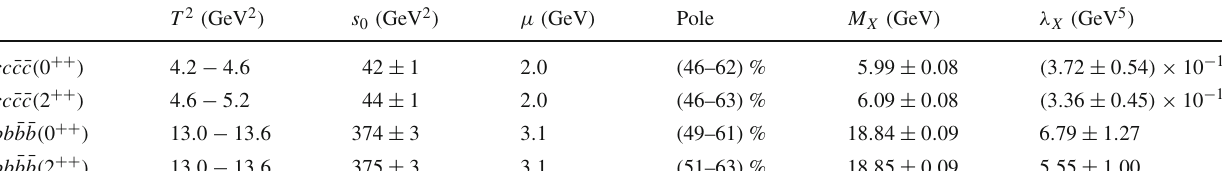
Table 1 The Borel parameters, continuum threshold parameters, energy scales, pole contributions, masses and pole residues of the tetraquark states